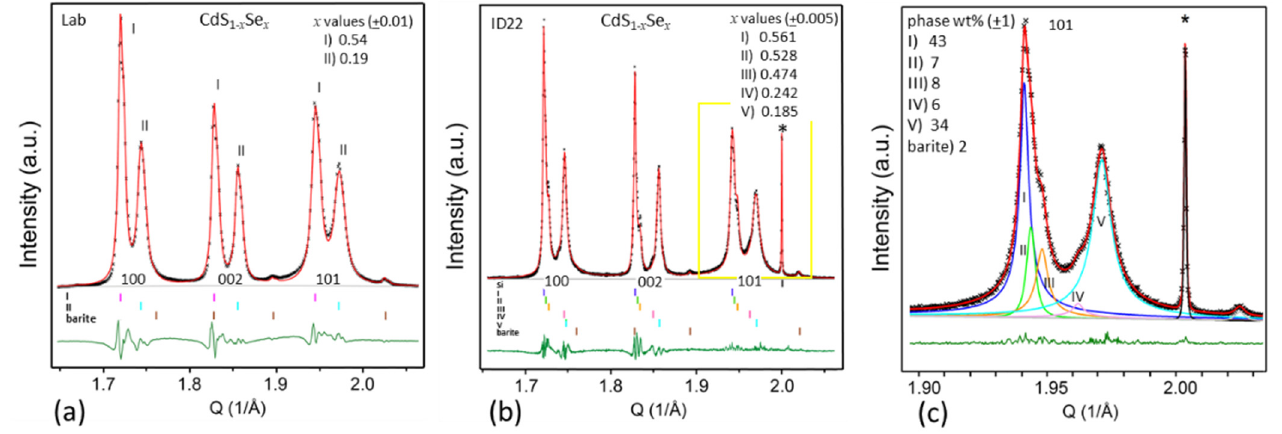
Figure 3. Portions of the Rietveld plots of the historical cadmium red pigment powder 442, showing the (100), (002), and (101) reflections of CdS 1 − x Se x phases, collected using ( a ) the laboratory diffractometer and ( b ) the ESRF-ID22 beamline. ( c ) Enlargement of the frame marked in yellow in ( b ) showing, in different colors, the contributions of the five CdS 1 − x Se x phases to the (101) reflection. The refined x values (and their standard deviation) for the different phases are reported in box ( a ) and ( b ), while the weight % of the five identified phases, plus barite, are reported in box ( c ), as resulting from the Rietveld analysis [37]. Black cross: experimental data; red line: calculated profile; dark green line: difference curve. Vertical marks indicate the calculated positions of Bragg reflections for each crystalline phase. The peak of silicon, used as internal standard, is marked with an asterisk